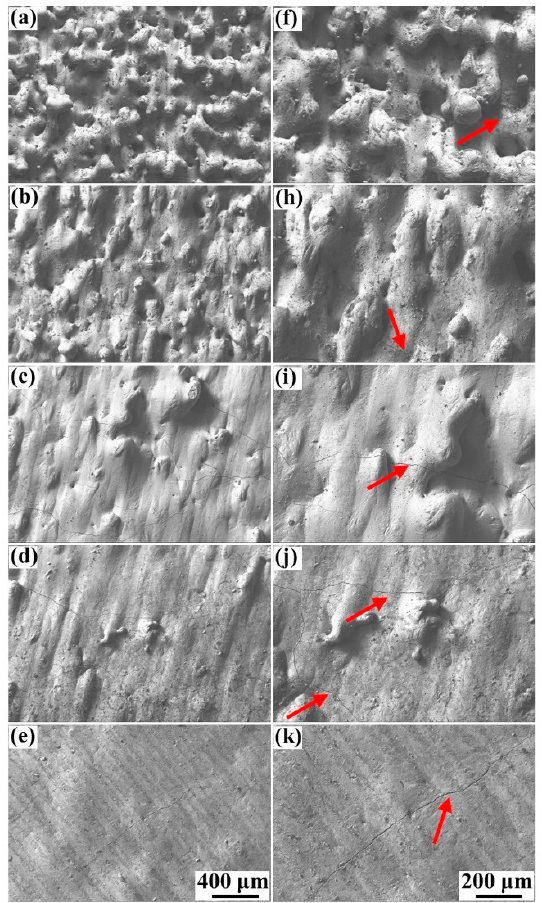
Figure 5. The top surface morphology of the specimens formed at 370 mm/s under the Scan II strategy: ( a – e ) Laser power from 95 to 215 W, ( f – k ) the large magnification corresponding to ( a – e ).